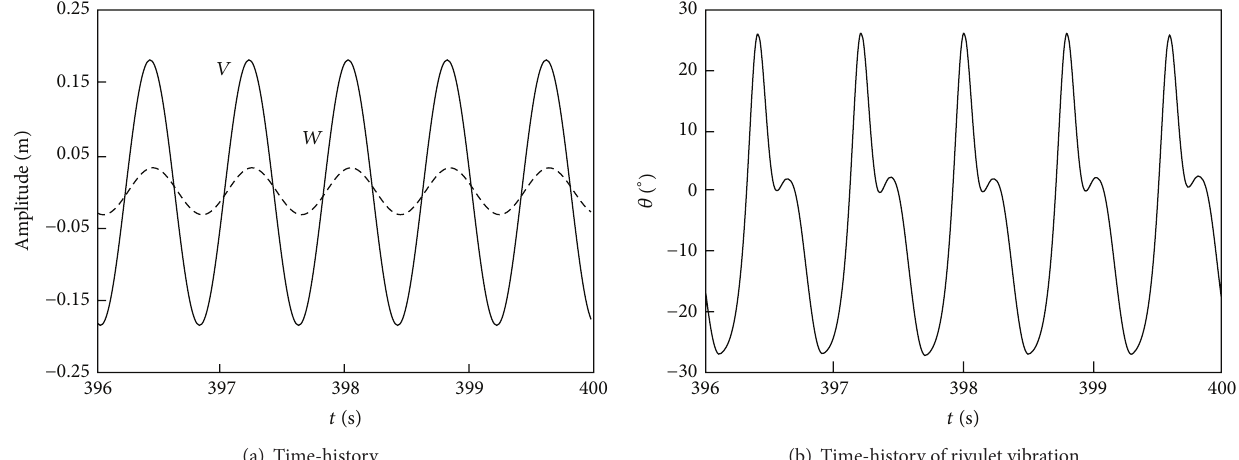
Figure 2: Displacements of in-plane and out-of-plane